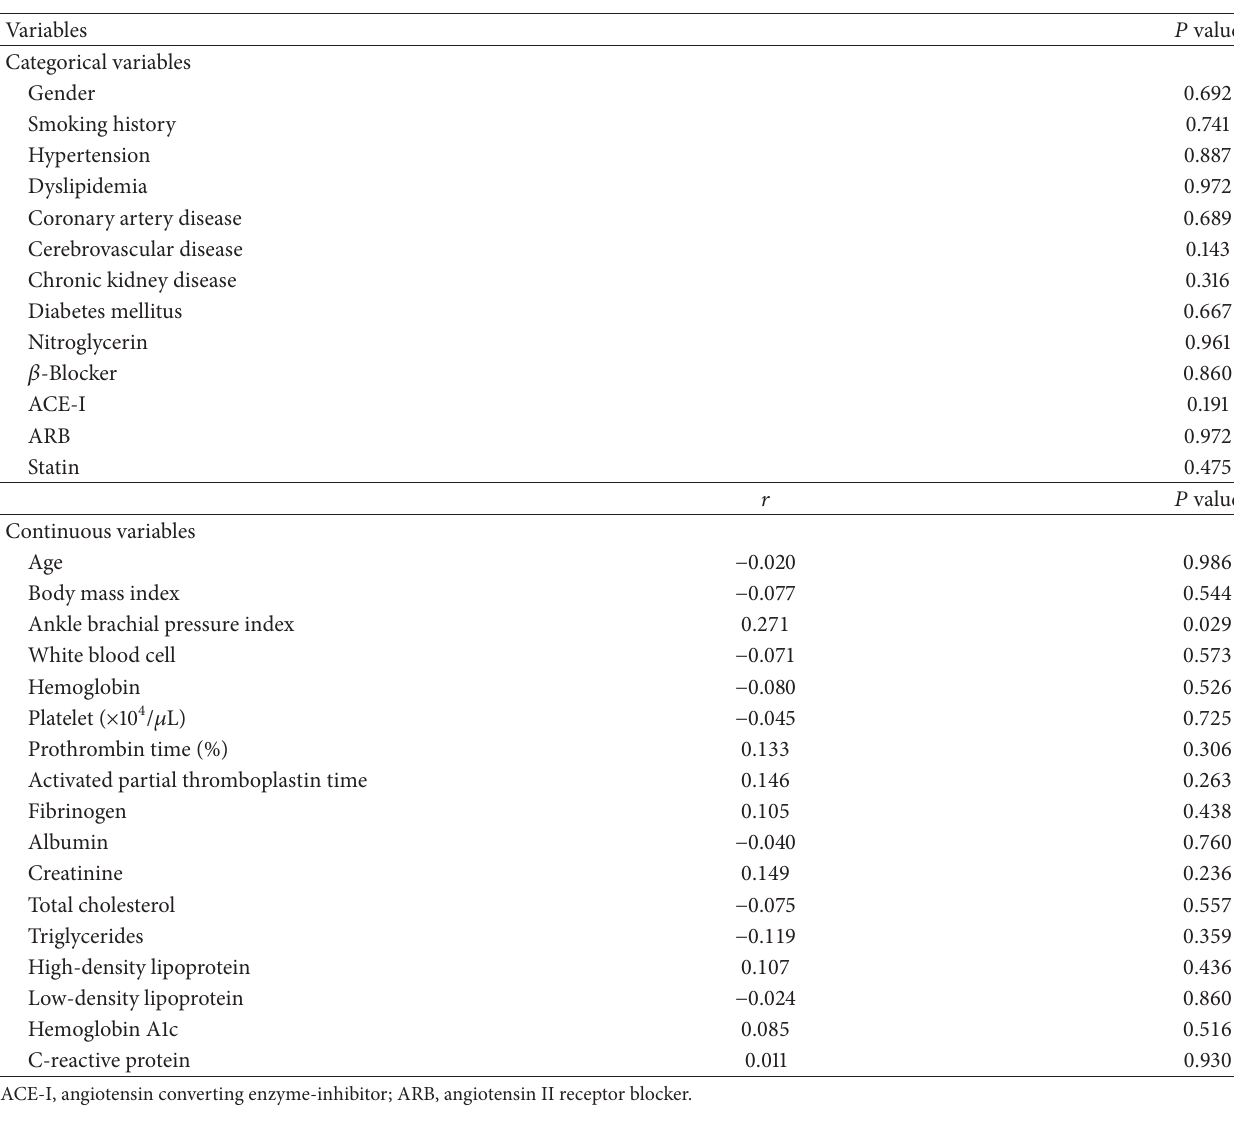
Table 2: Univariate analysis of the correlations between endothelial function and various